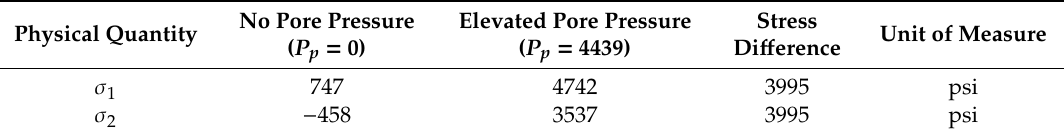
Table 3. Principal stress magnitudes at x = 10 and y = 10.